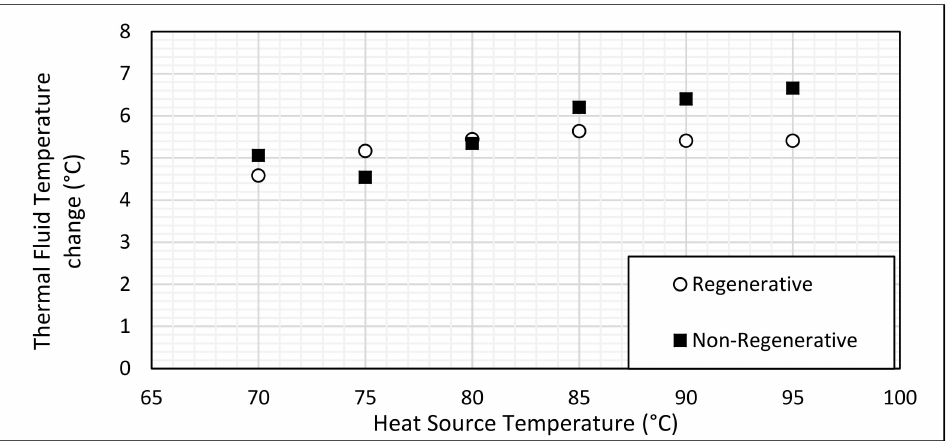
Figure 14. Plot of the temperature change in the thermal fluid with changing heat source temperature for the regenerative and non-regenerative